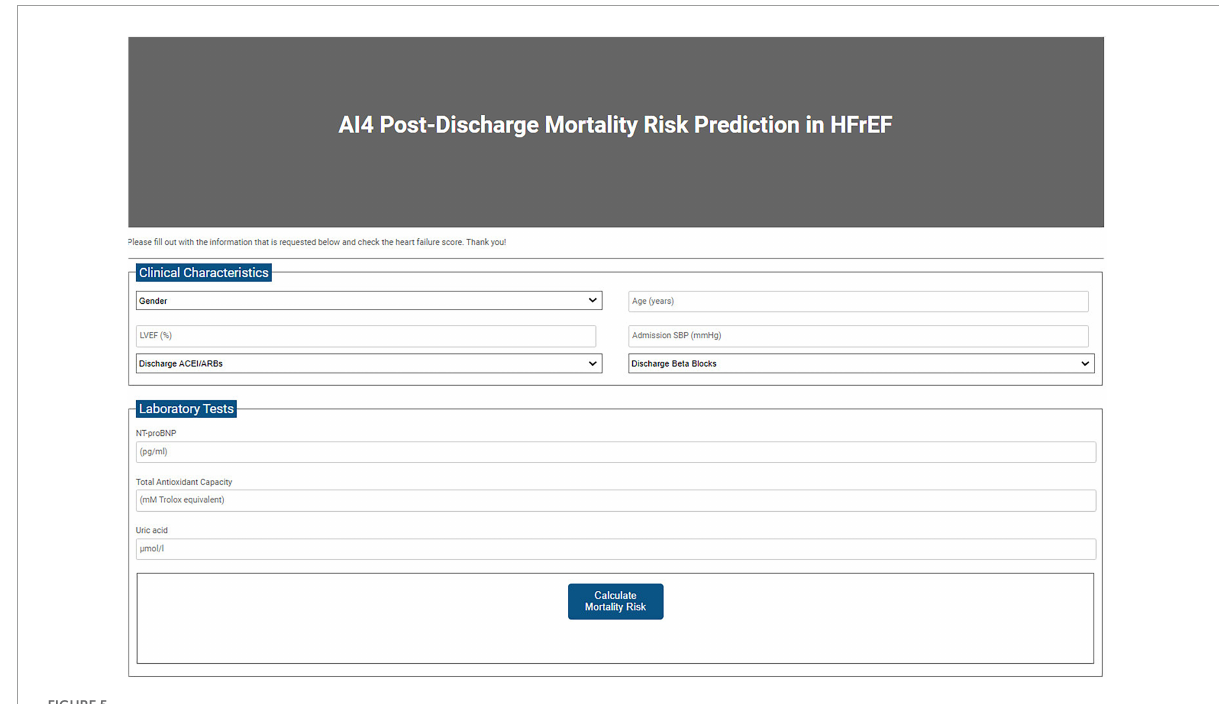
FIGURE5 Post-discharge mortality risk